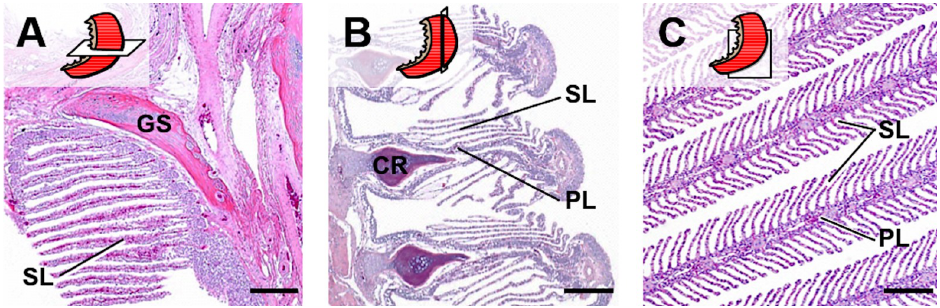
Fig 3. Appearance of histological gill section profiles in different section plane orientations (schematically indicated). A. Transverse section. B. Frontal section. C. Sagittal section. Important morphological structures are indicated: GS : Gill arch support skeleton, CR : Cartilage rod, PL : Primary gill lamellae, SL : Secondary gill lamellae. Haematoxylin and Eosin (HE)-stained sections of formalin-fixed and paraffin-embedded (FFPE) gills. Bars = 200 μ m.